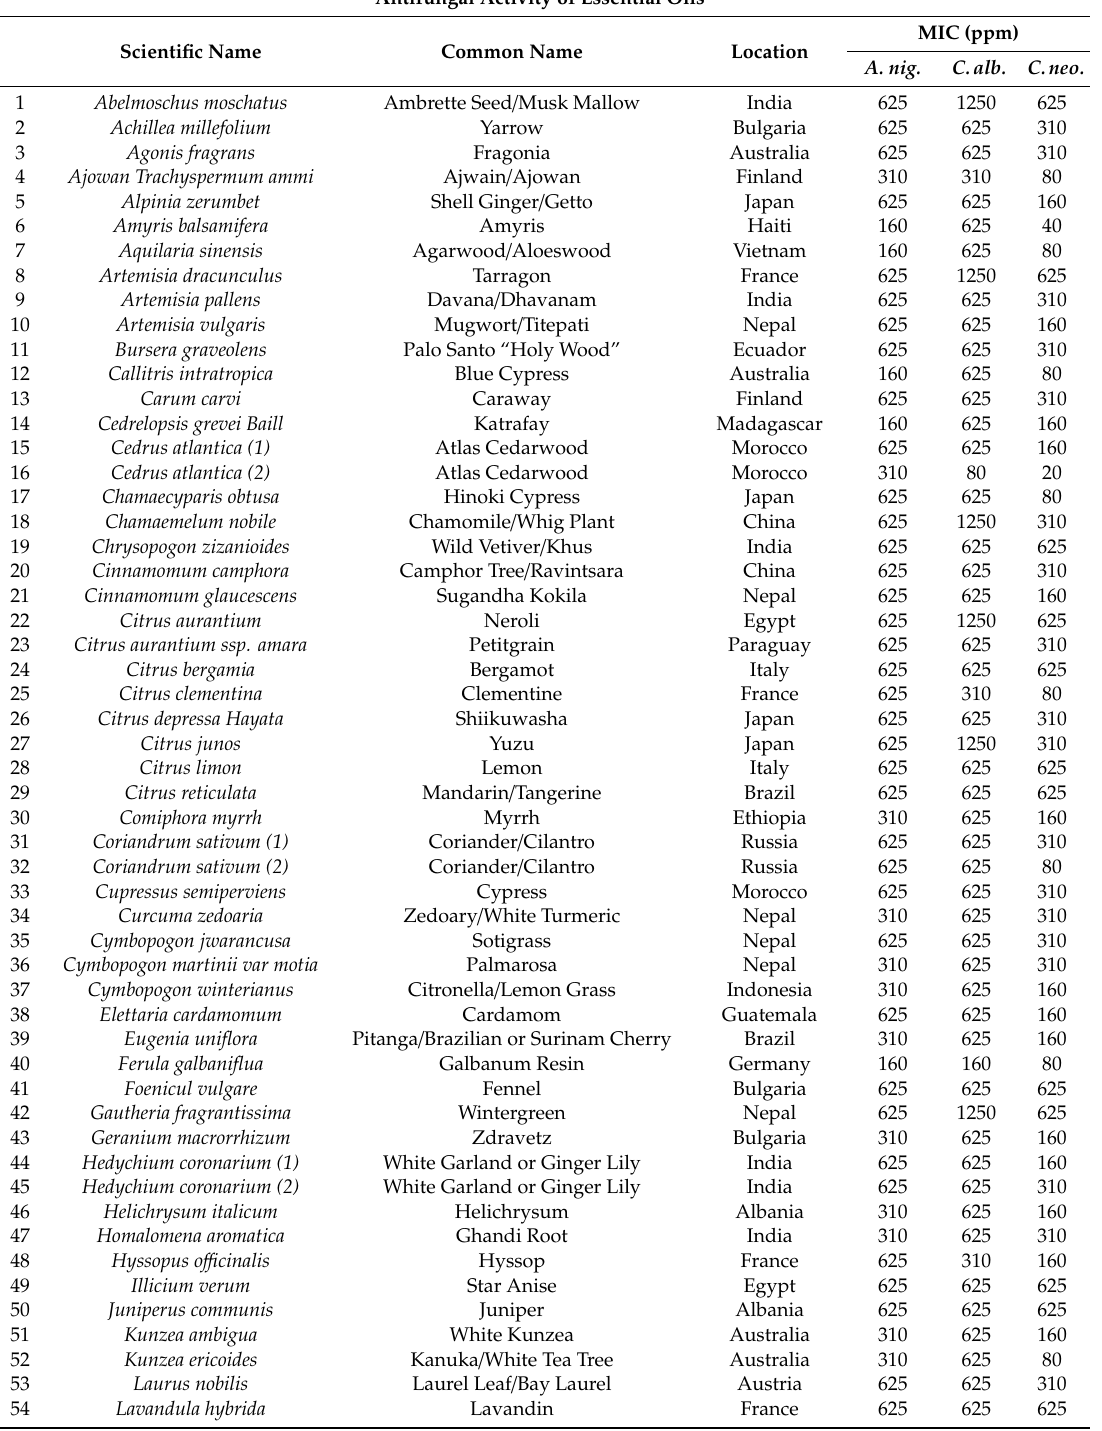
Table A1. Antifungal Activity of Essential Oils. MIC data are shown for each essential oil against the three pathogenic fungi tested